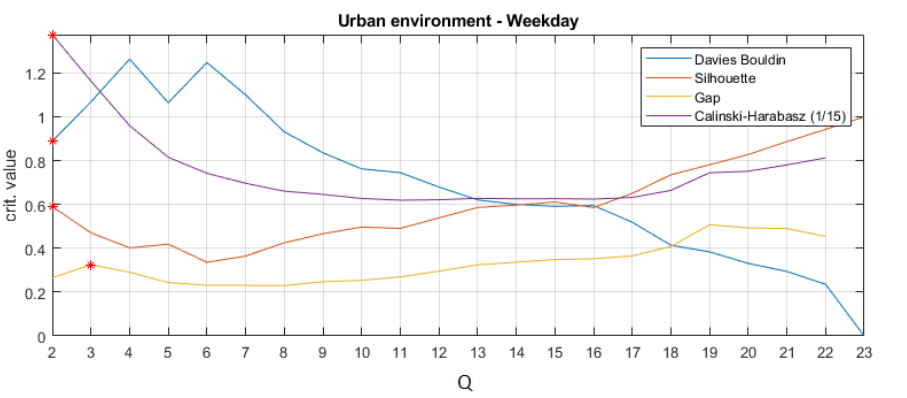
Figure 12. Clustering validity indices obtained for the acoustic urban environment on the weekday, resulting from the agglomerative hierarchical clustering algorithm for the considered number of clusters sweep 2 ≤ Q ≤ 23. The suboptimal number of clusters are marked as red asterisks, being the local maxima in all clustering indices despite the Davies–Bouldin index, which is a local minimum.